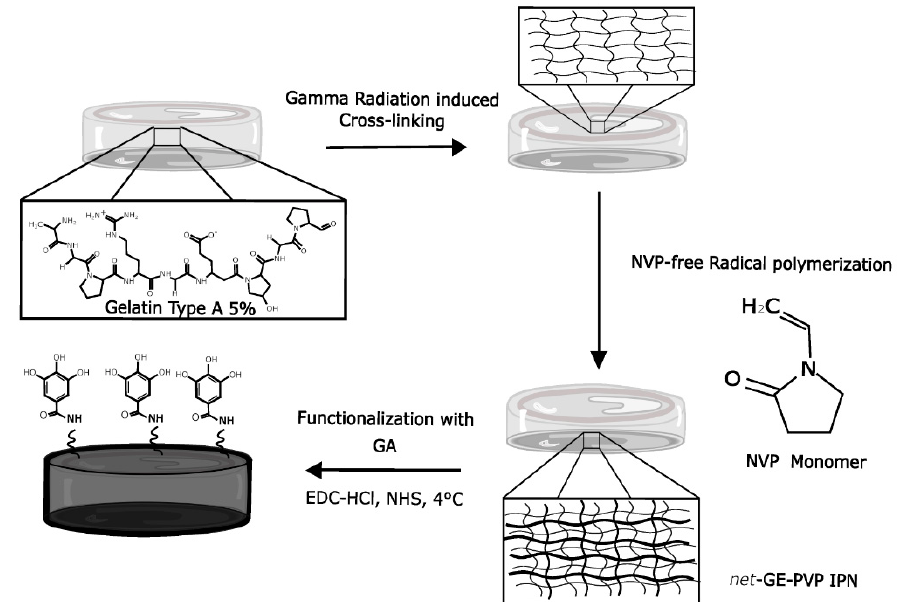
Figure 1. Scheme of the synthesis route to obtain GA-functionalized IPN hydrogels.